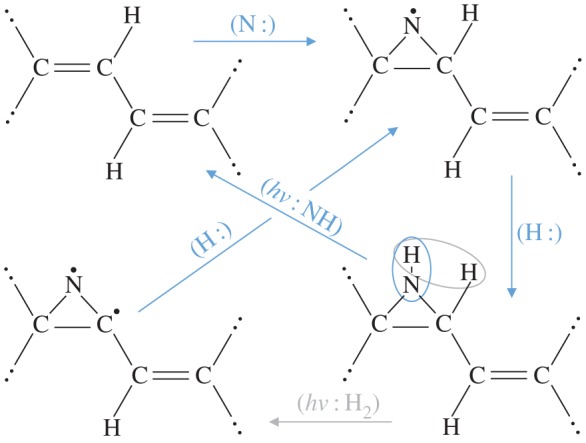
A formation pathway for nanoparticle surface aziridine groups and the catalytic formation and the liberation of H2 molecules and NH radicals following UV photolysis in the tenuous ISM.